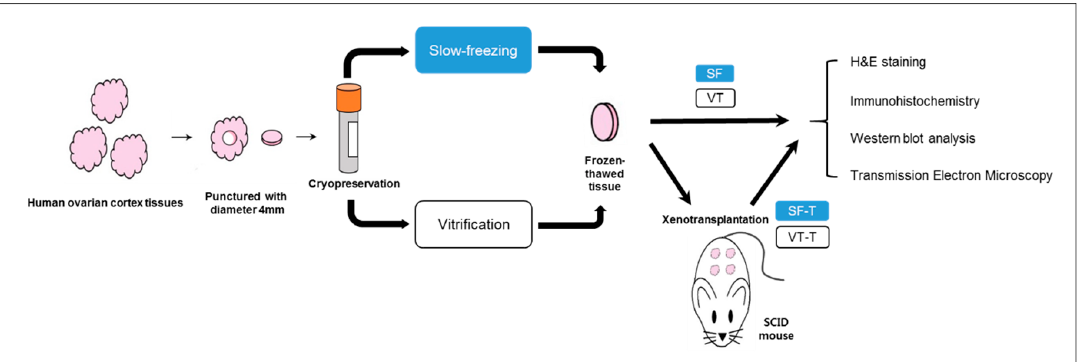
Figure 8. Schematic representation showing the experimental design of this study. Human ovarian cortex tissues were punctured to make same size with diameter 4 mm, and those samples were cryopreserved with slow freezing or vitrification methods. After 4 weeks, the thawed samples underwent histological analyses or were transplanted into SCID mice. The transplanted samples were retrieved after 4 weeks and underwent histological analyses. Abbreviations are: SF, cryopreserved with slow freezing technique and thawed group. VT, cryopreserved with vitrification technique and thawed group. SF-T, the group xenotransplanted after slow freezing and thawing. VT-T, the group xenotransplanted after vitrification and thawing, and SCID, severe combined immunodeficient.